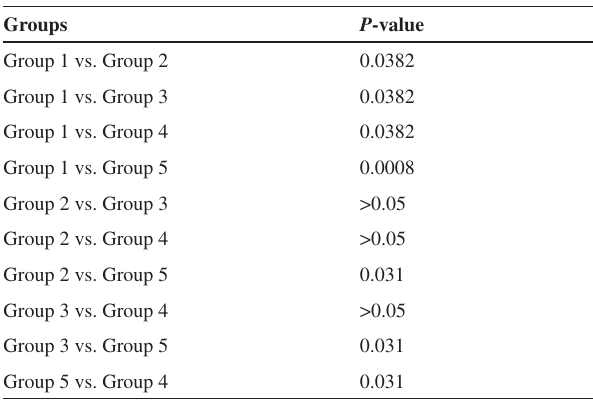
Table 4 - Statistical comparison of the groups according to the adhesion grade